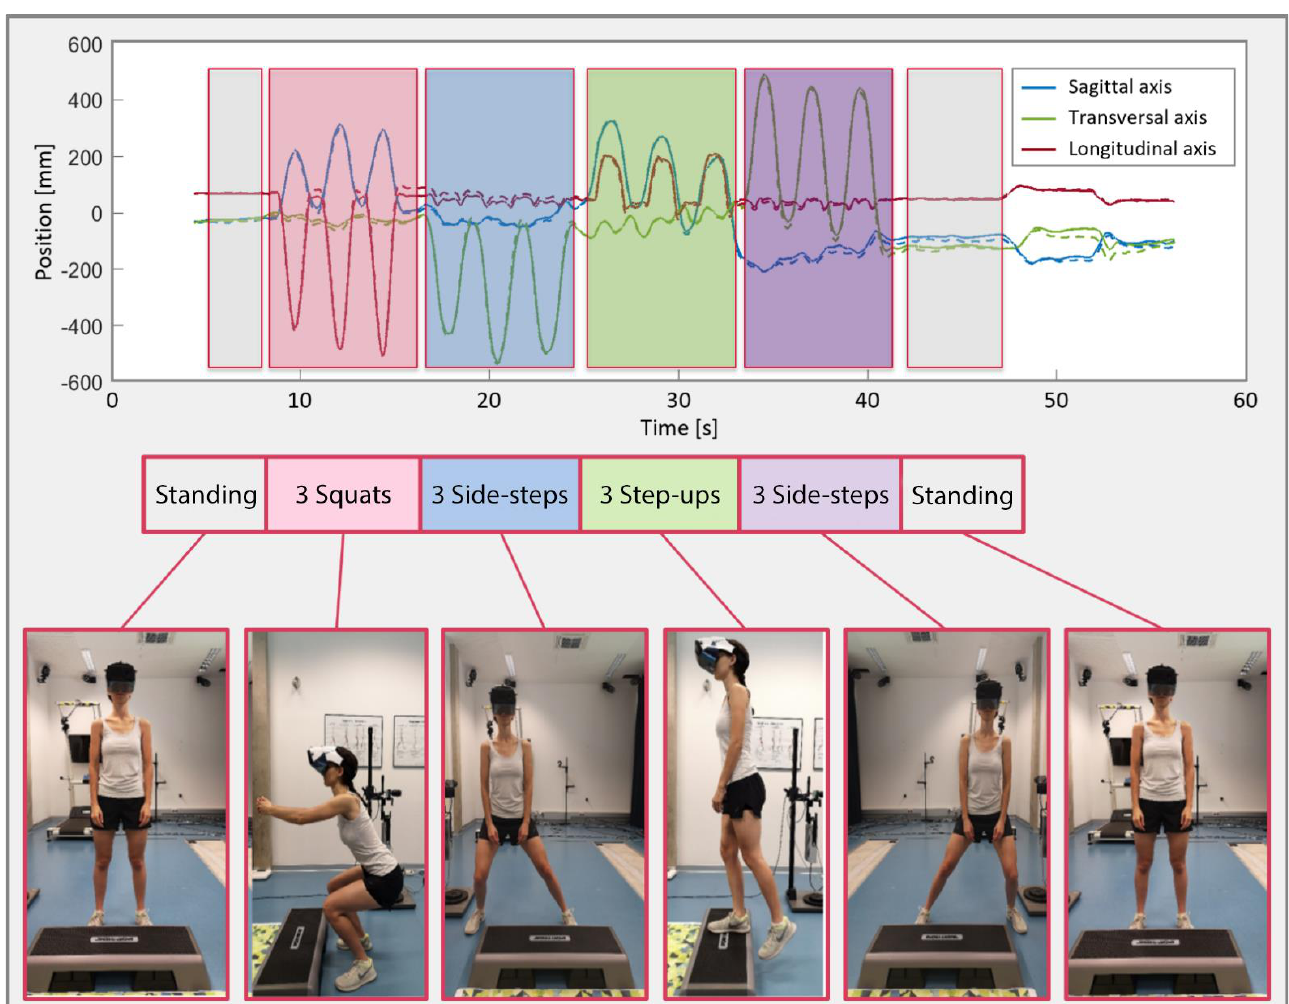
Figure 3. Example of the position trajectories of all spatial planes of one subject recorded with the TG (dashed line) and Table 3. DMAS (solid line) during Trial 1 with an illustration of the procedure. The dashed line is only visible in the case of larger differences between the two measurement systems.